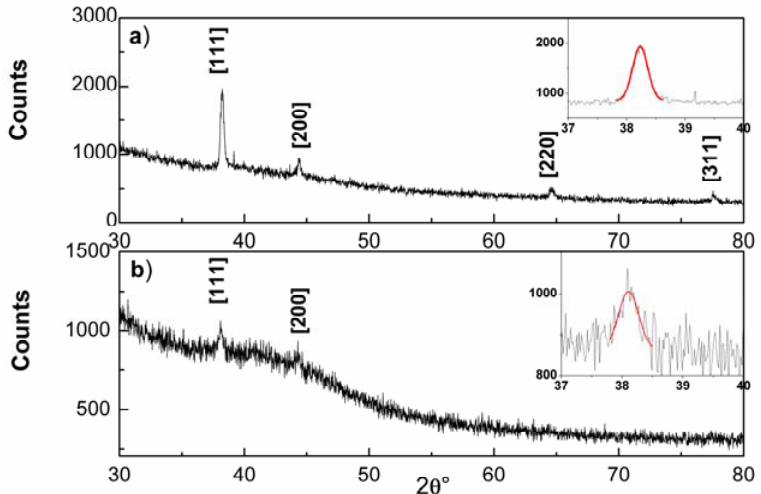
Figure 2. (a) X-Ray Diffraction (XRD) spectrum of nanocomposite obtained by thermal decomposition of silver n-dodecyl-mercaptide and (b) spectrum of nanocomposite obtained by thermal decomposition of silver cyclohexyl-mercaptide. The insets show the curve fitting of [111] diffraction peaks used to calculate the peak width at half-height for nanoparticles’ size estimation from Scherrer’s